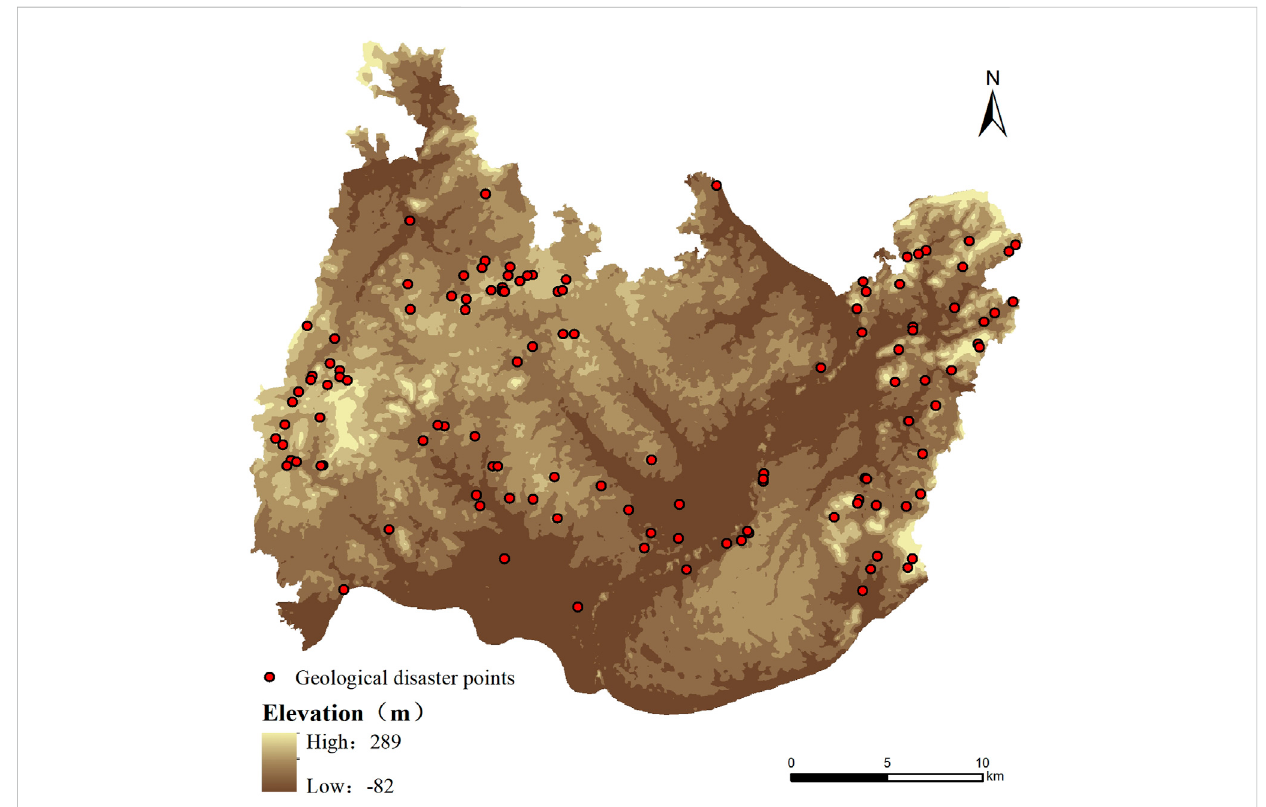
FIGURE 1 Geological hazard distribution map of Xiangtan urban area.